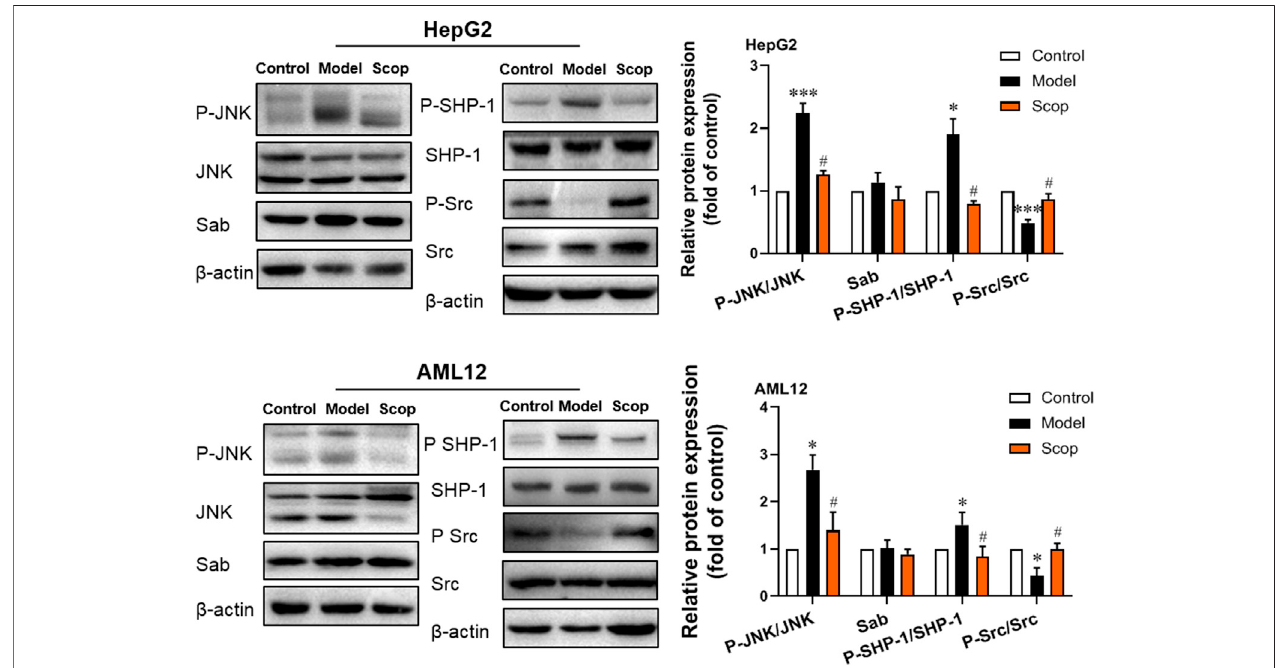
FIGURE 5 | Scoparone inhibited PA-induced activation of JNK/Sab signaling pathway in hepatocytes. The expression and activation levels of JNK, SHP-1, Src, and Sab protein in HepG2 and AML12 cells with PA induction were detected and analyzed. * p < 0.05, *** p < 0.001 vs. Control; # p < 0.05 vs. Model.